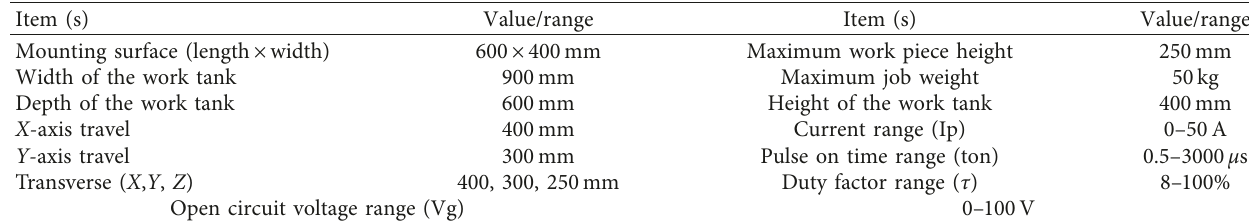
Table 3: Specification of EDM